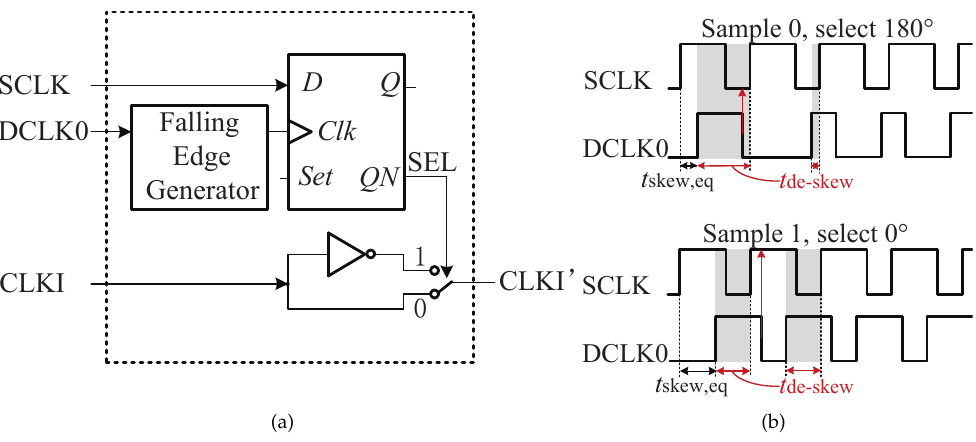
Figure 6. The structure and adjustment strategy of FPA. ( a ) Structure; ( b ) adjustment